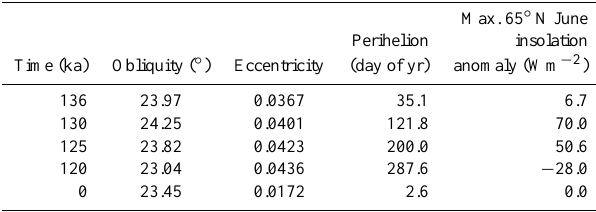
Table 2. The orbital parameters (from Milankovitch theory) for four time snapshots between 140 and 120ka (Berger and Loutre, 1991) and the maximum 65 ◦ N June insolation anomaly. Also shown for comparison are the parameters for the pre-industrial